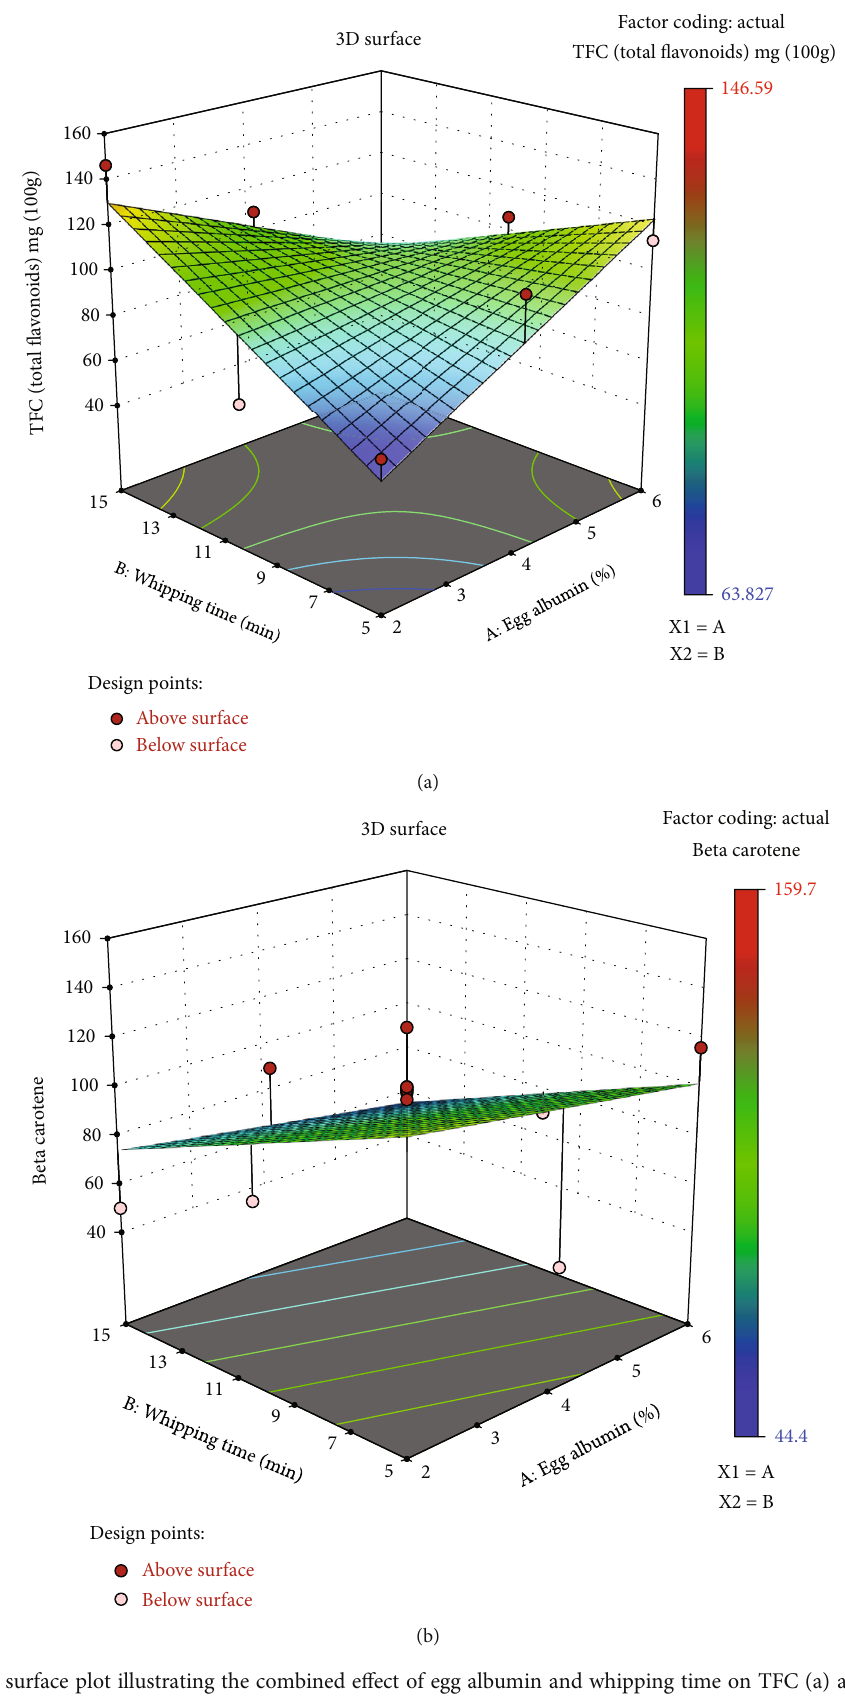
Figure 6: Response surface plot illustrating the combined e ff ect of egg albumin and whipping time on TFC (a) and beta carotene